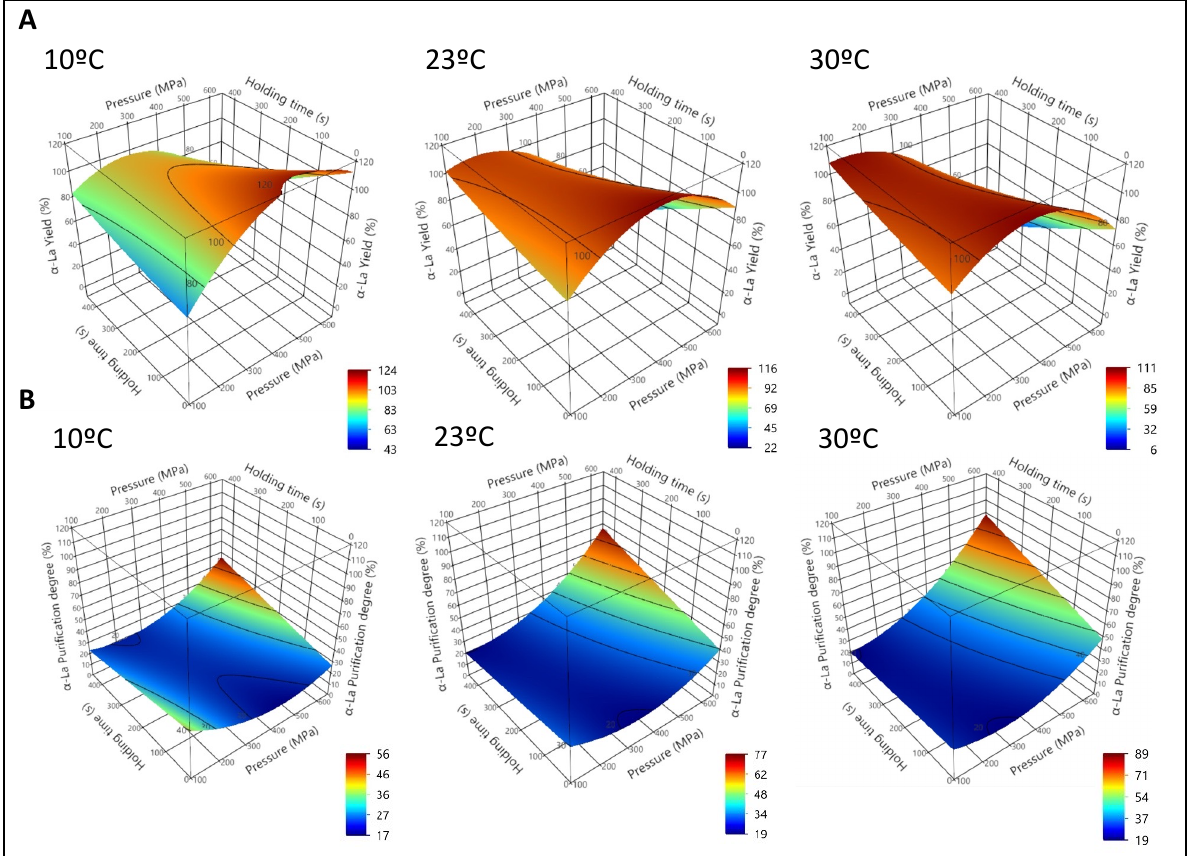
Figure 1. First experiment. Native whey concentrate supernatant (NWC sup ) at physiological pH. Representation of the surface responses for α -Lactalbumin yield ( A ) and α -La purification degree ( B ) after high pressure processing (HPP) treatments as a function of pressure (P), holding time (t) and initial sample temperature (10 °C, 23 °C and 30 °C), according to the equations from Table S2.